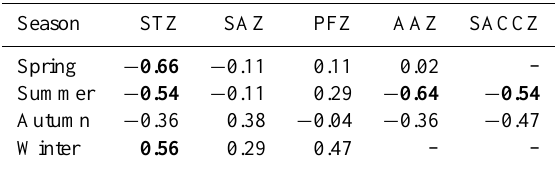
Table 4. Kendall’s rank correlations between NPP and SST in the five frontal zones.